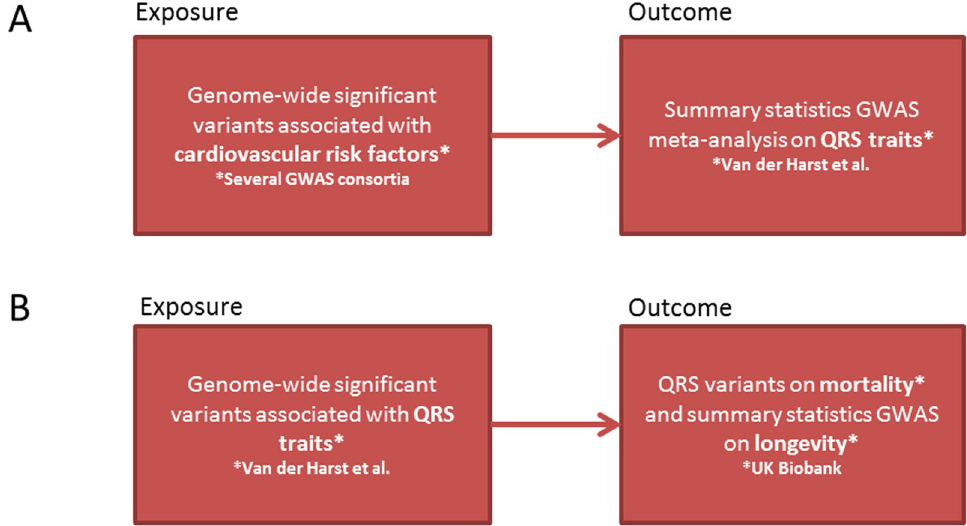
Figure 1. Flow charts of the MR analyses performed. ( A ) Is the schematic presentation of the MR analyses of cardiovascular risk factors on QRS traits to determine which cardiovascular risk factors causally lead to changes in QRS duration and QRS amplitude. ( B ) Is the schematic presentation of the MR analyses of QRS traits on mortality and longevity to determine whether a causal relationship of QRS traits with mortality and longevity exists.